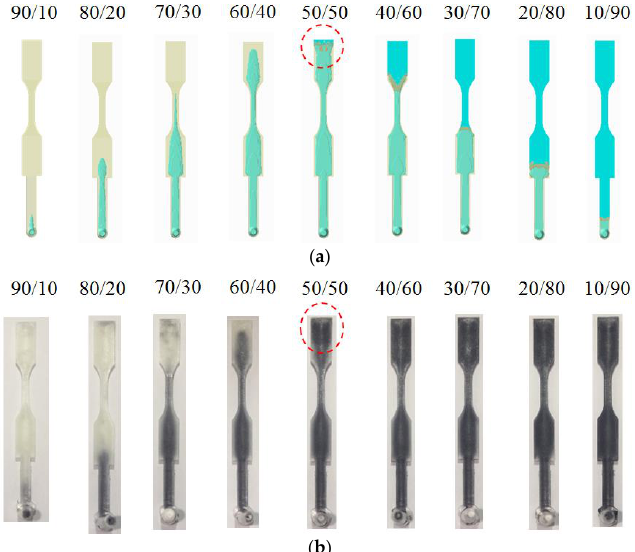
Figure 4. Core material advancement at various skin to core ratio, from 90/10 to 10/90 of 30SFPP/30SFPP arrangement, at 10 cm 3 /s: ( a ) simulation and ( b ) experiment.